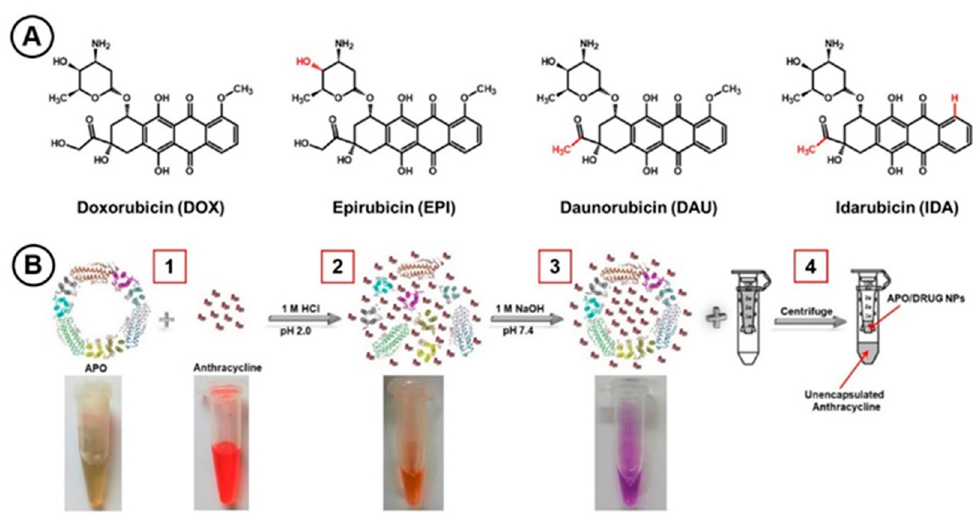
Figure 1. ( A ) Structures of anticancer drugs of the anthracycline group. ( B ) Schematic illustration of anthracycline encapsulation in an apoferritin nanocage forming an APO (drug) nanocarrier. The steps 1 to 4 are described in the text.